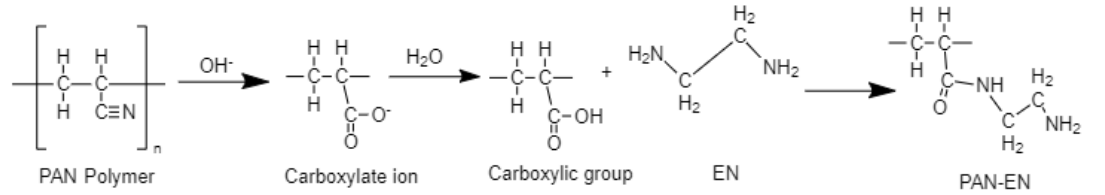
Figure 4. Functionalization of PAN membrane using ethylenediamine under alkaline conditions.